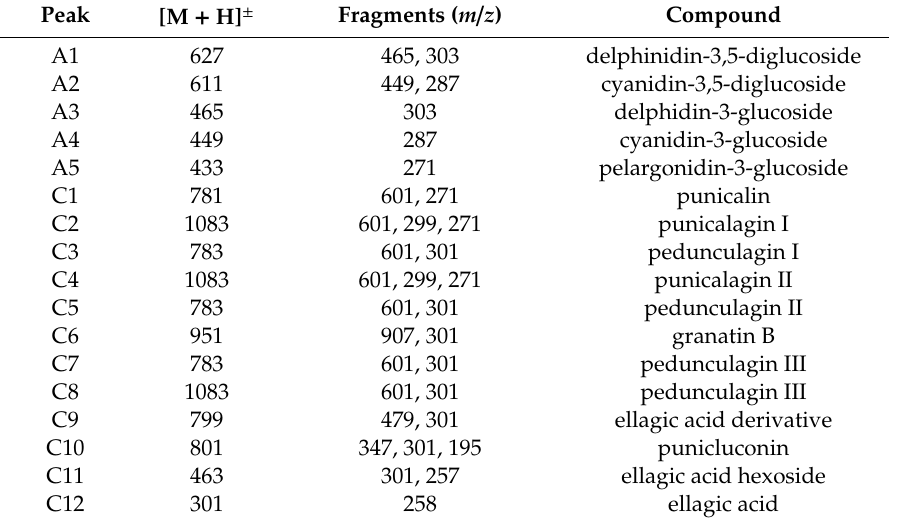
Table 1. Identification of the compounds of an anthocyanin and copigment fraction of the XAD-7 extract of pomegranate ( Punica granatum L.) by HPLC electrospray ionization tandem mass spectrometry (HPLC–ESI–MS /